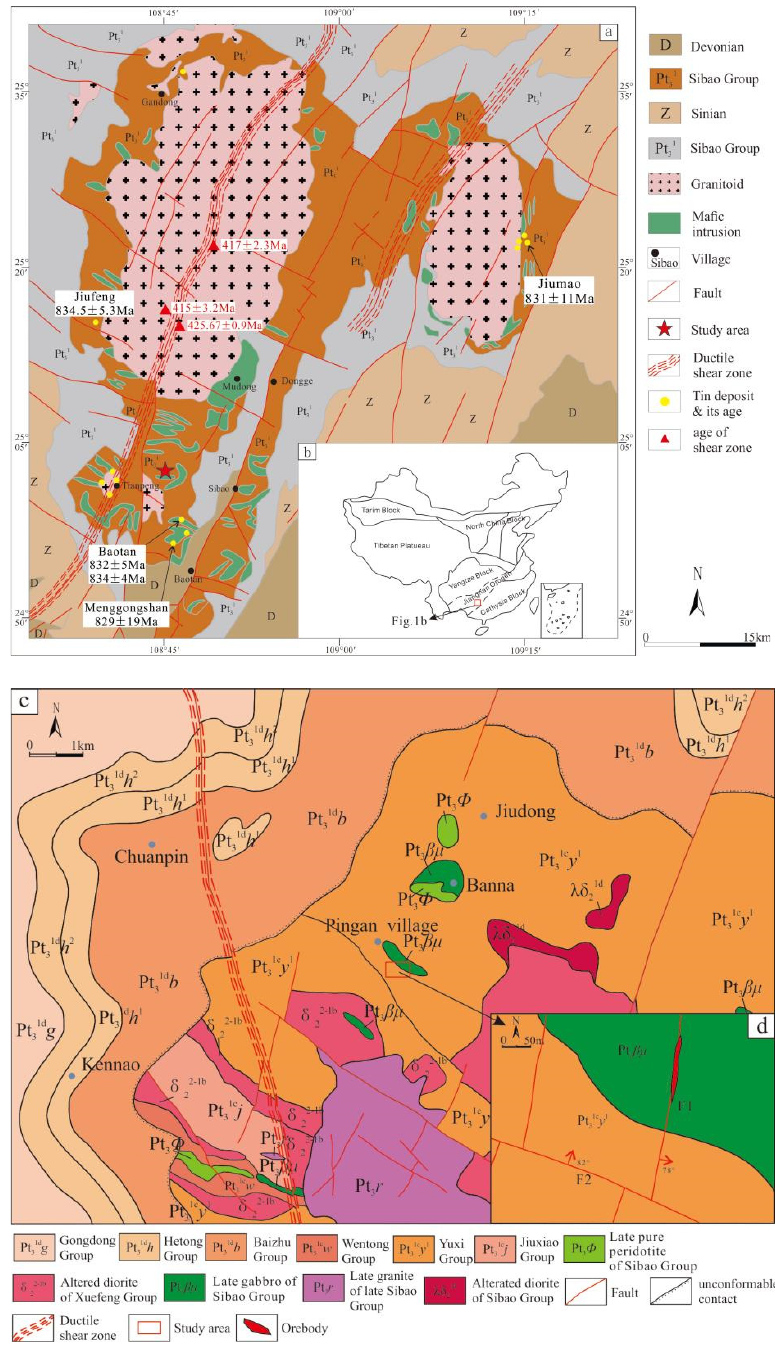
Figure 1. Regional geological and mineralization geological maps [1–4,19] (modified after Mao et al., 1988; Wang et al., 2006; Zhang et al., 2016, 2019). ( a ) Simplified geological map of the study region of Jiuwangdashan–Yuanbaoshan, northern Guangxi Province; ( b ) simplified tectonic map of China; ( c ) geological mining map of the Ping’an Pb–Zn–Cu deposit, showing the location of study area; ( d ) geological map of the study area, showing one of the distribution of ore bodies.